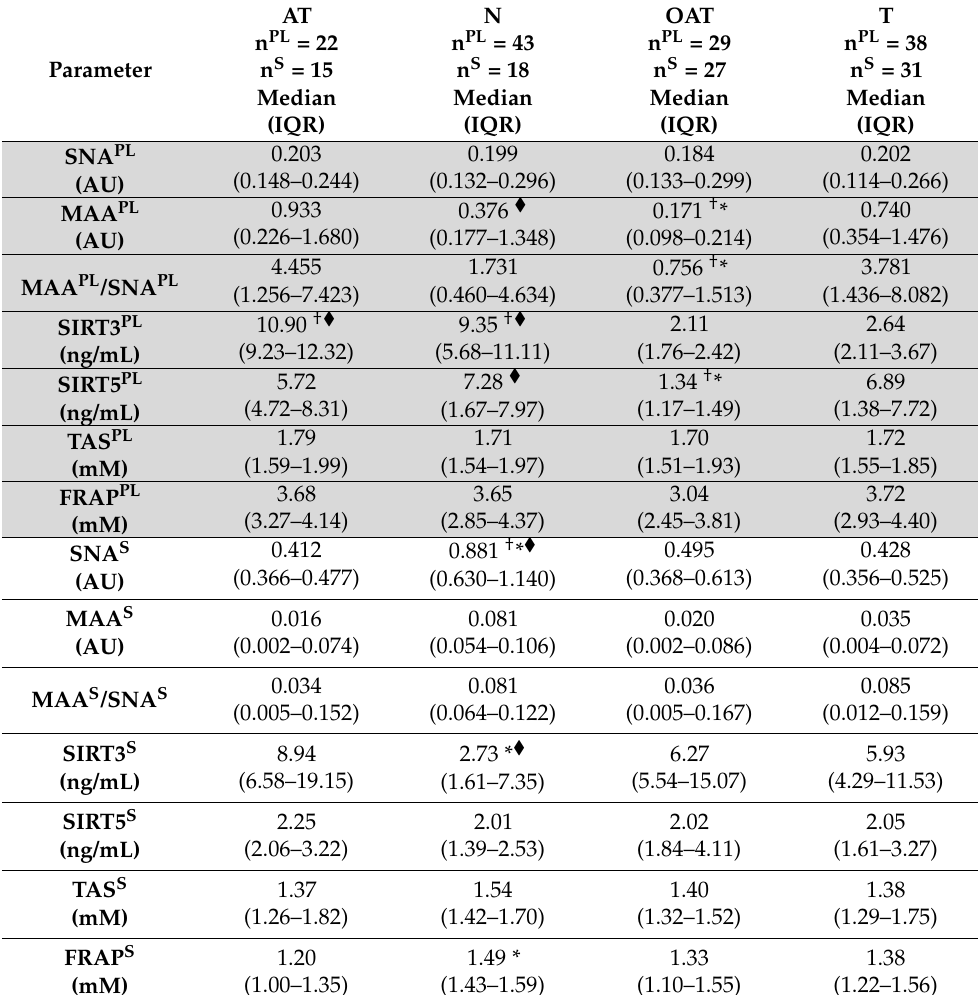
Table 1. The values of seminal plasma and blood serum parameters analyzed in groups of patients with fertility problems.